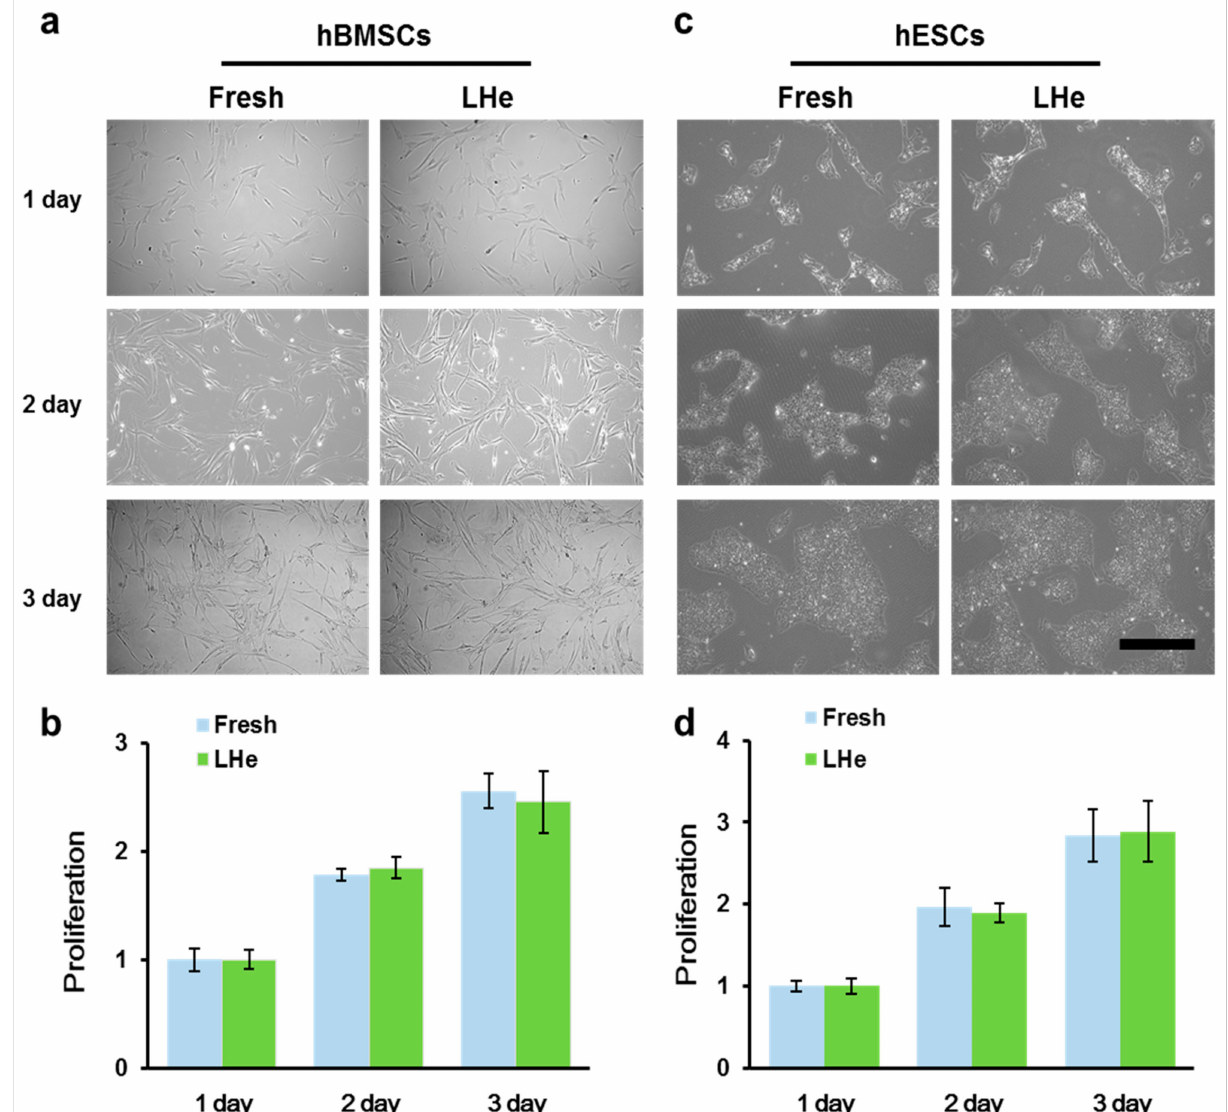
Figure 5. Cell morphology and proliferation were not impacted post vitrification. ( a ) Morphology and ( b ) proliferation of fresh and vitrified hBMSCs. ( c ) Morphology and ( d ) proliferation of fresh and vitrified hESCs. There was no significant difference in proliferention every day between group Fresh and LHe both for hBMSCs and hESCs. LHe: vitrification in LHe. Scale bar: 200 µ